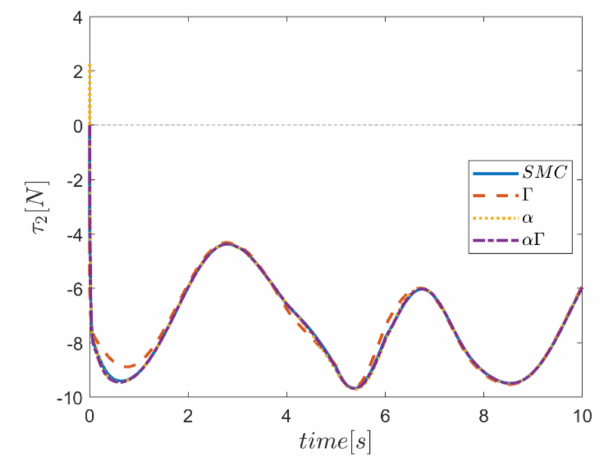
Figure 29. Comparison of the input force in the second